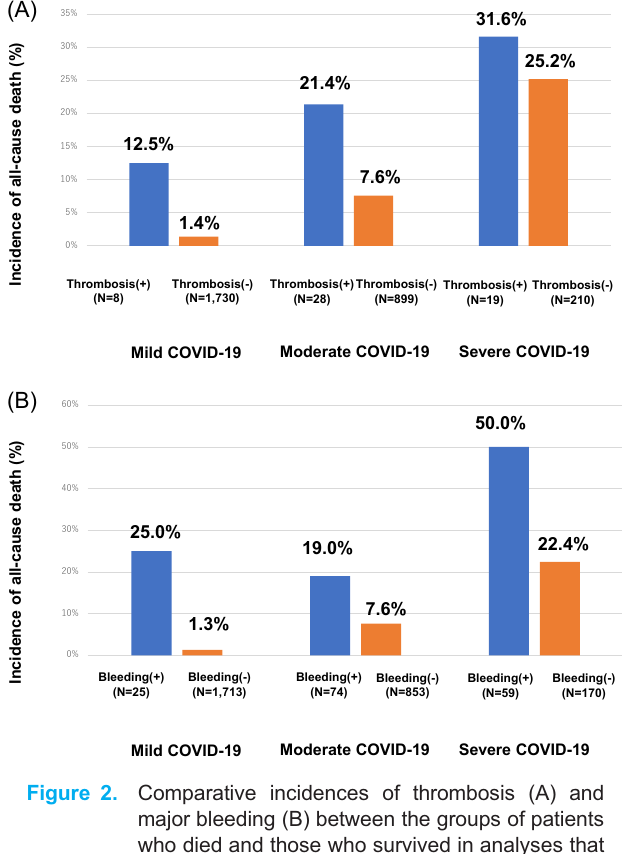
Figure 2. Comparative incidences of thrombosis (A) and major bleeding (B) between the groups of patients who died and those who survived in analyses that were strati fi ed by the COVID-19 severity on admis- sion. COVID-19, novel coronavirus disease 2019.